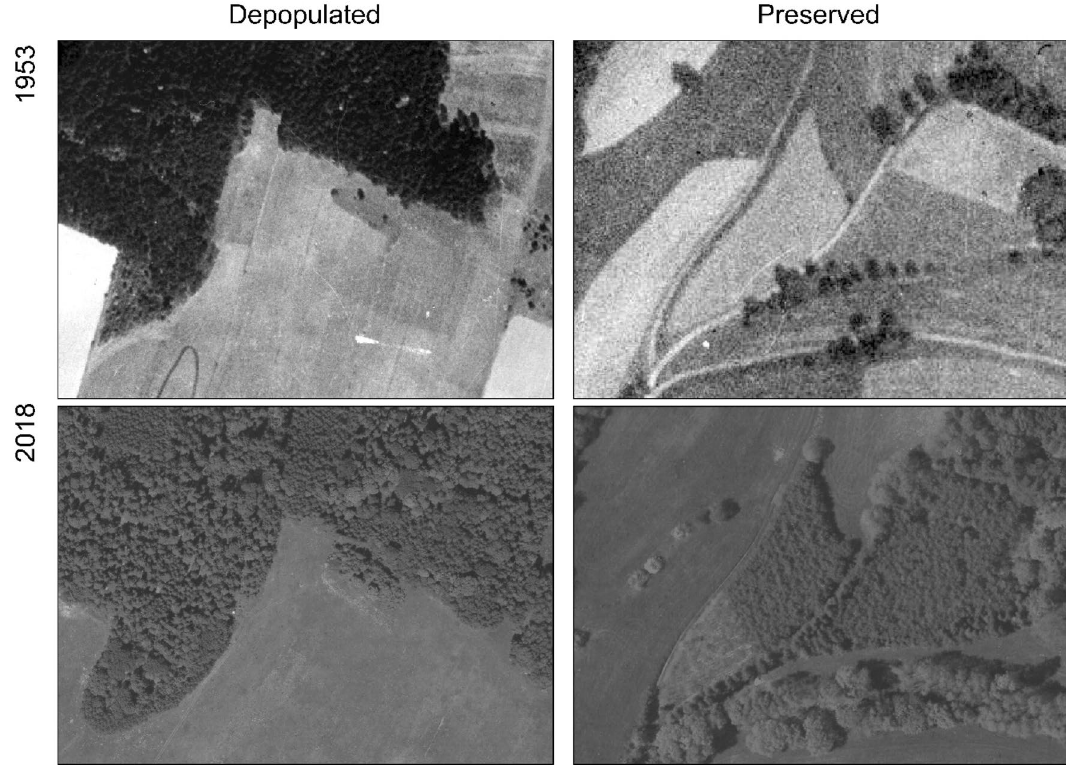
Figure 8. Noticeable visual difference in the dynamics of a new forest. Spontaneous succession and controlled afforestation (sources of aerial data: orthorectified images from 1953 36 , colour orthorectified images from 2016 to 2017 40 ,maps generated in the ArcGIS 10.6 software 34